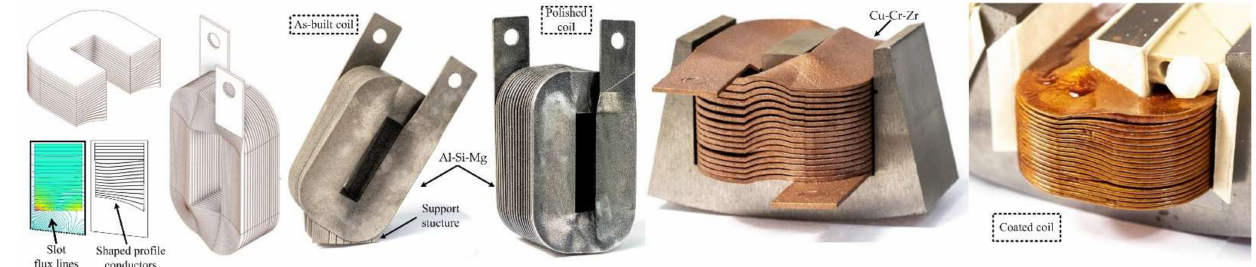
Figure 13. AM shaped-profile coils with low AC loss for high-speed electrical machines